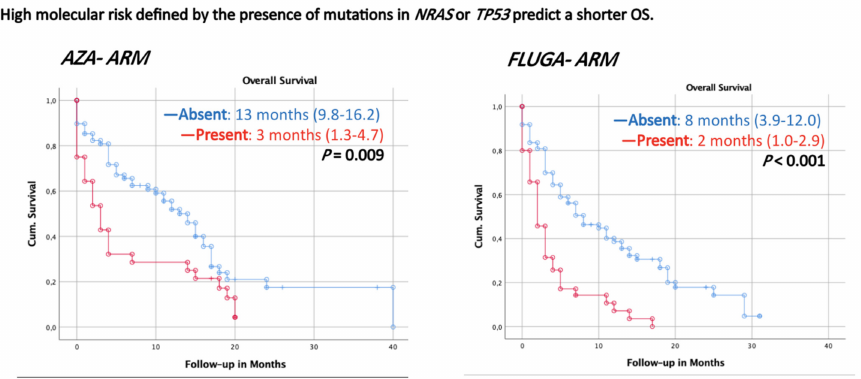
Figure 4. Kaplan–Meier overall survival curves in acute myeloid leukemia (AML) patients classified by the presence or absence of high molecular risk score (HMR). HMR pattern defined by presence of NRAS or TP53 mutations which is associated with unfavorable outcomes and shorter survival after azacytidine ( left ) or FLUGA ( right ) schemes. HMR absent is indicated in blue and HMR present is indicated in red. Number of censored patients with respect to the stratified groups and the number at risk is indicated. p values are considered significant ( p < 0.05). OS: overall